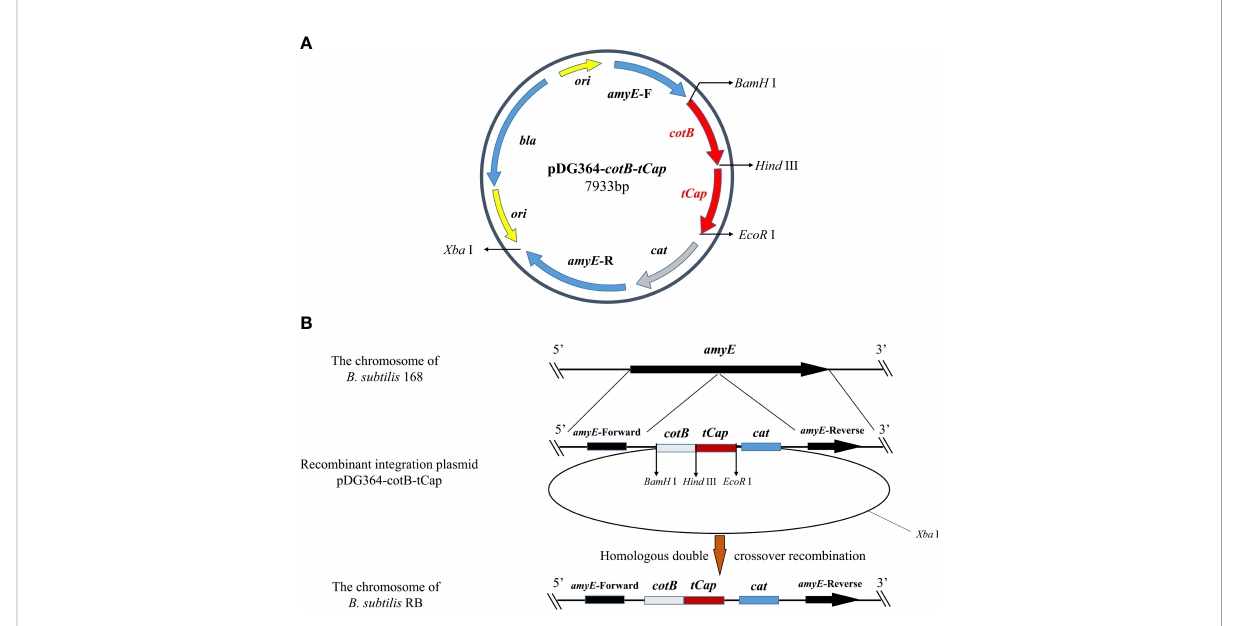
FIGURE 2 Homologous recombination between integration plasmids pDG364- cotB - tCap and the B . subtilis 168 genomes. (A) Map of the plasmid vector pDG364- cotB - tCap2. (B) Homologous double crossover recombination between the recombinant plasmid pDG364- cotB - tCap and the genome of B . subtilis